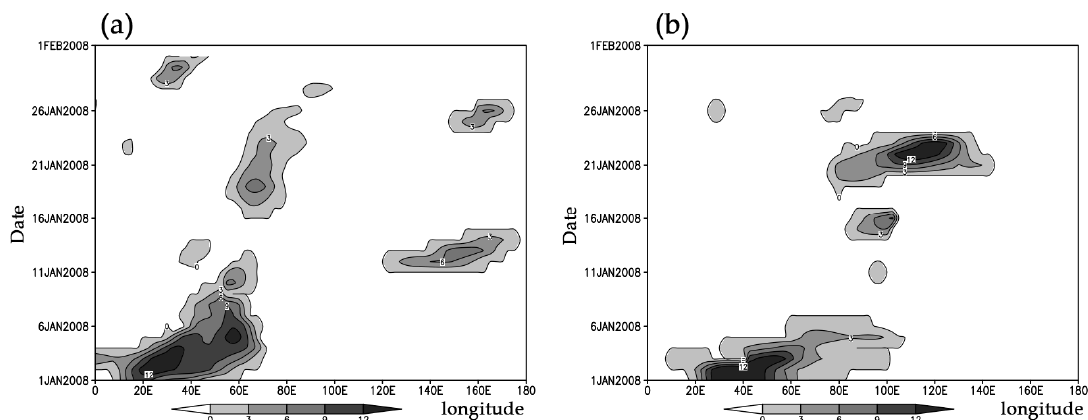
Figure 1. Tibaldi and Molteni (T&M) blocking index in Eurasian middle and high latitudes during the two events. Unit: m · degree − 1 . ( a ) from January 1 to February 1 2008, ( b ) from January 1 to February 1